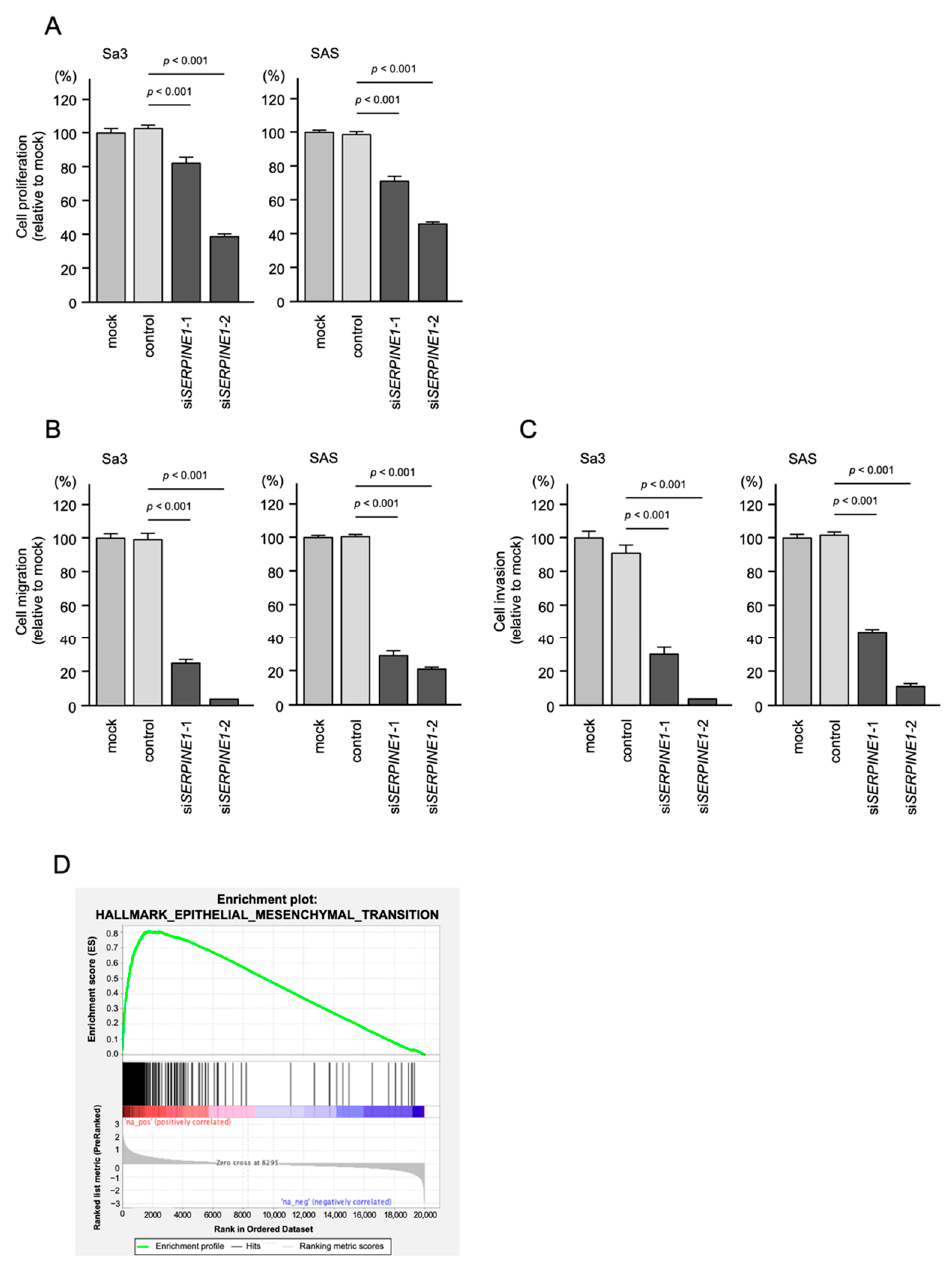
Figure 7. Functional assays of cell proliferation, migration, and invasion following the transient transfection of siRNAs targeting SERPINE1 in HNSCC cell lines (Sa3 and SAS cells). ( A – C ) Functional assays of cell proliferation, migration, and invasion following the transient transfection of si SERPINE1– 1 and si SERPINE1– 2 in HNSCC cell lines (Sa3 and SAS cells). ( A ) Cell proliferation assessed by XTT assay at 72 h after siRNA transfection. ( B ) Cell migration assessed using a membrane culture system at 48 h after seeding miRNA-transfected cells into the chambers. ( C ) Cell invasion assessed by Matrigel invasion assays at 48 h after seeding miRNA-transfected cells into chambers. ( D ) GSEA analysis showed that most enrichment pathway was “epithelial–mesenchymal